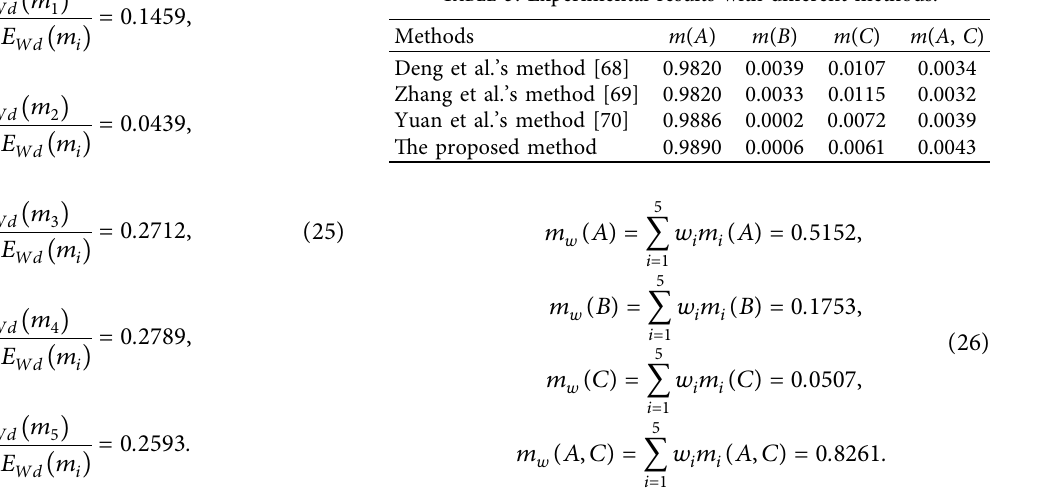
Table 3: Experimental results with different